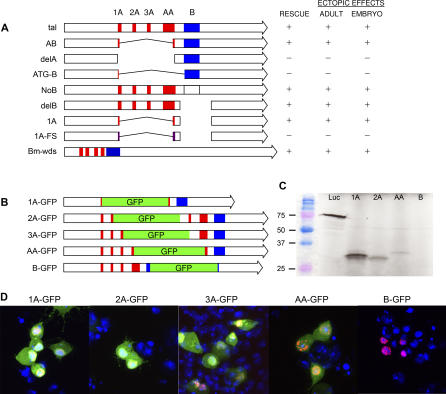
Directed Mutagenesis and Translation of tal
(A) In these constructs, the coloured boxes indicate ORFs, and deletions are represented as empty segments. Engineered new ORFs are represented by bridged boxes. The UAS-tal construct contains the full cDNA and produces the complete rescue of the tal phenotypes and ectopic effects shown in Figures 1 and 4. Construct AB comprises one type-A ORF and one ORF-B, and produces the same functional effects. Construct delA has no type-A ORF and produces no effects. ATG-B forces translation of ORF-B, but still shows no effects. NoB has a mutation of the putative start codon of the ORF-B (empty box), thus preventing its translation, and produces the same functional effects as UAS-tal. delB has ORF-B deleted and is also fully functional. The 1A construct, which consists of the AB construct plus the deletion delB, contains only one type-A ORF and mimics the tal functional effects. In the construct 1A-FS, a single G was introduced after the start codon, causing a frameshift, which would result in the translation of a spurious 13-codon ORF (purple box). This construct is not functional. The Bm-wds construct contains one of the Bombyx tal full-length cDNAs and mimics the Drosophila UAS-tal results.(B) UAS-tal-GFP constructs tagging different ORFs, showing the in-frame insertion of the GFP coding sequence (green)(C) Peptides of expected size produced in vitro by Luciferase (61 kDa, control), 1A-GFP, 2A-GFP (28.4 kDa), and AA-GFP (33.1 kDa), but none by B-GFP (expected size, 31.6 kDa) The amount of protein produced seems to decay from 5′ to 3′ according to the ORF position, ORF 1A being the highest, and ORF AA the lowest.(D) UAS-tal-GFP constructs transfected into S2R+ cells. 1A-GFP, 2A-GFP, 3A-GFP, and AA-GFP (green) are detected, but not B-GFP. DAPI labels nuclei (blue), and nuclear DsRed transfected cells (red).